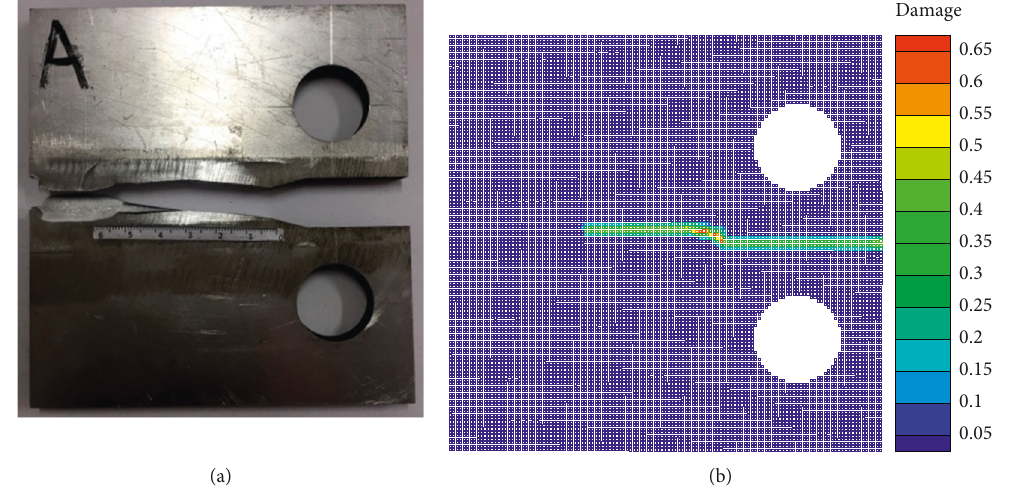
Figure 8: Fatigue crack path comparison. (a) Experimental result of sample 3. (b) Peridynamic result of sample 3.